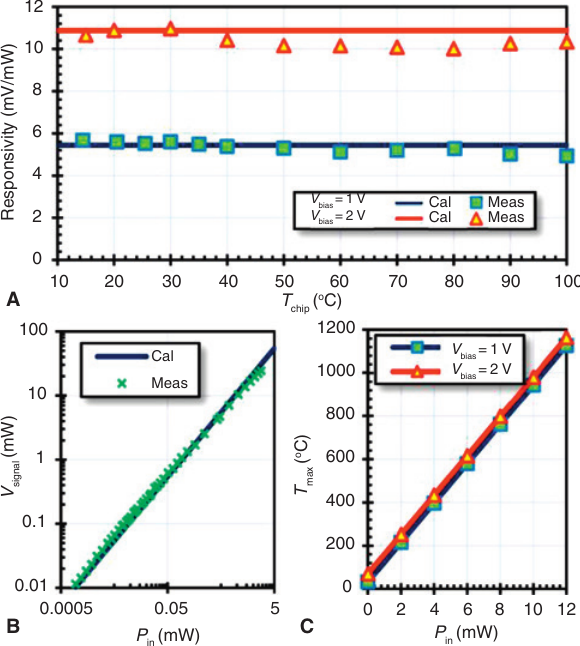
Figure 5: The temperature stability and the dynamic range. (A) Measured and calculated responsivity under different tem- peratures T controlled by a TEC when operating with V chip and 2 V. (B) Measured and calculated electrical signal V = 2 V as the input optical power power monitor operating at V bias P increases from ~ 0.9 μ W to ~ 2.85 mW. (C) Calculated highest in temperatures T in the metal strip as the input optical power P max = 400 nm and l = 15 μ m. The bias voltage is increases. Here, w m m = 1 and 2 chosen as V bias